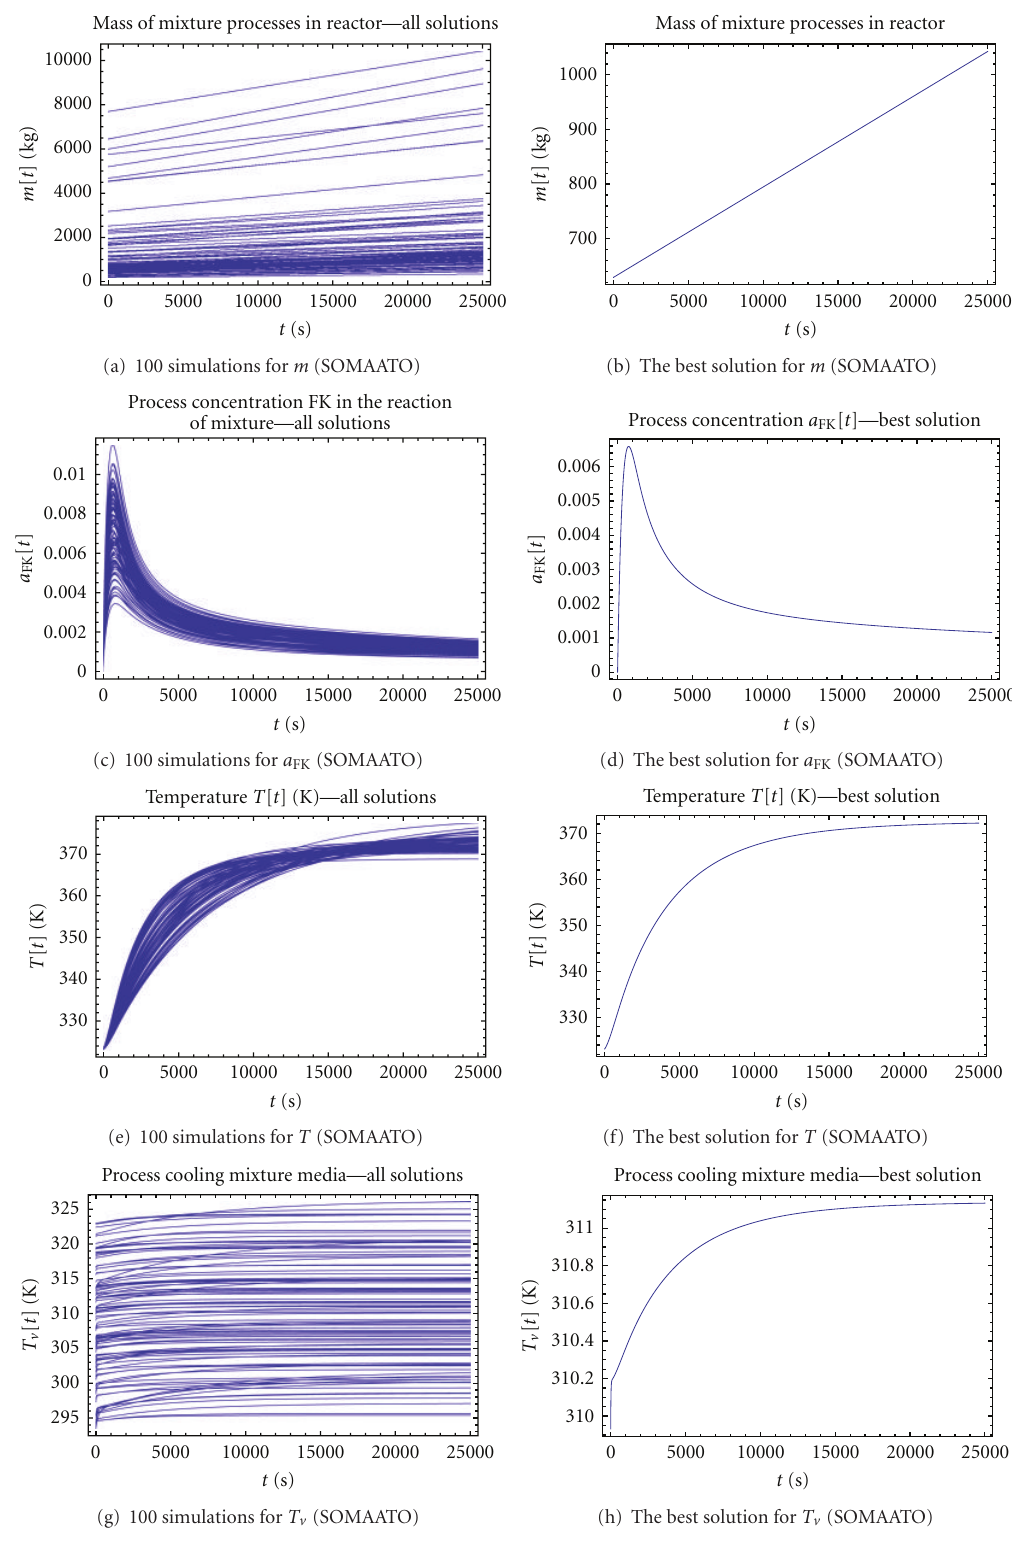
Figure 5: Processes parameters for 100 simulations of SOMA—version